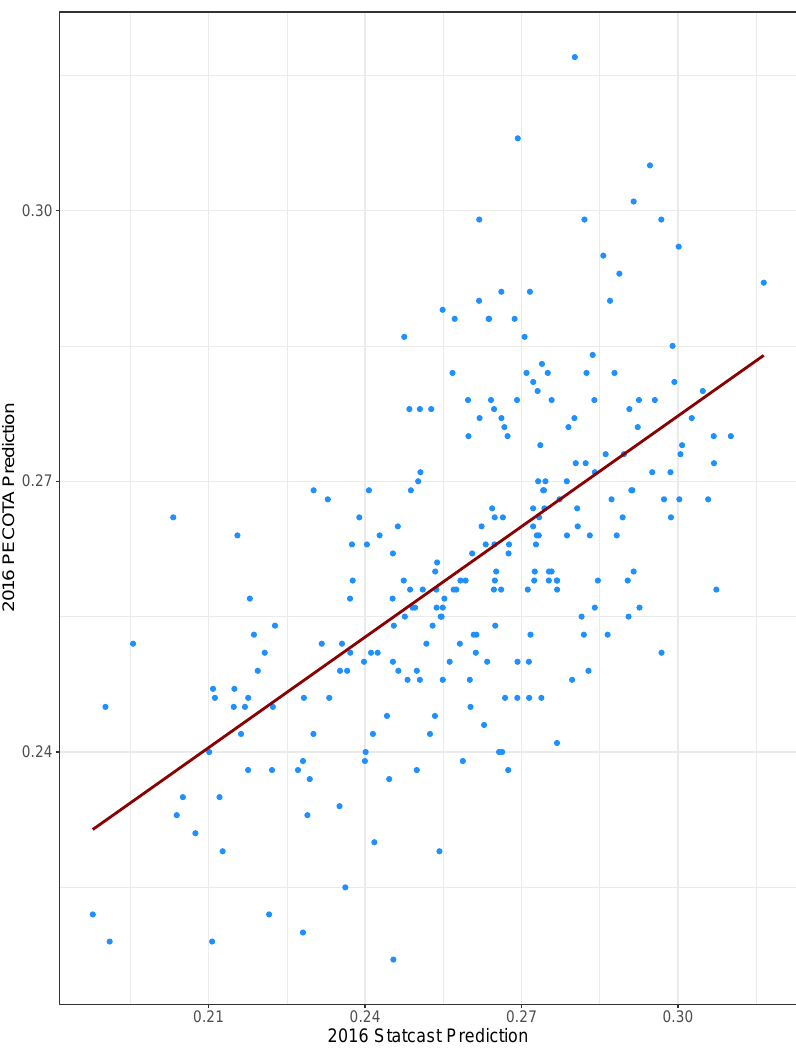
Figure 2. Statcast and PECOTA predictions for 2016 season. The line y = x has been added to aid in